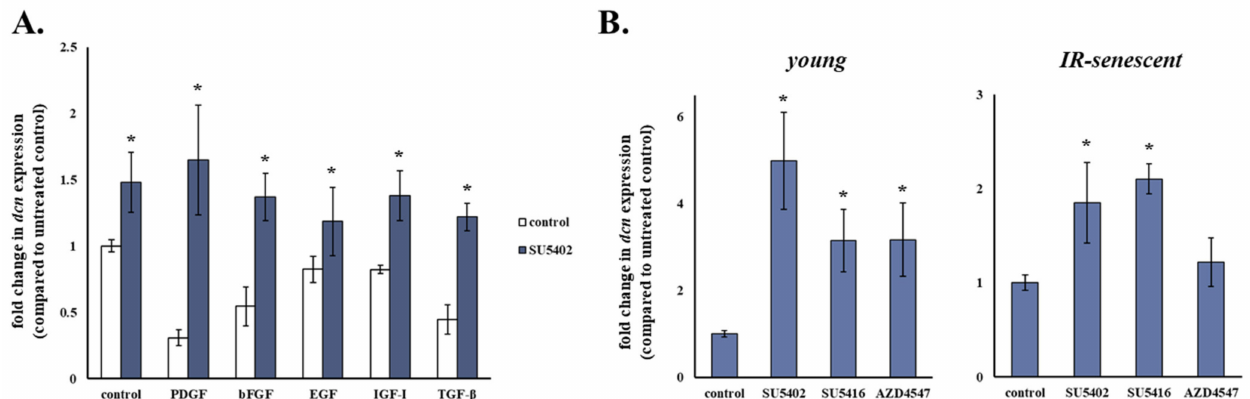
Figure 4. bFGF and VEGF seem to be the key growth factors down-regulating decorin expression in human stromal fibroblasts. ( A ) Human breast stromal fibroblasts were serum starved for 24 h, pre-incubated with 20 µ M of SU5402 for 1 h and then treated with PDGF (10 ng/mL), bFGF (10 ng/mL), EGF (100 ng/mL), IGF-I (100 ng/mL) or TGF- β (5 ng/mL) for another 24 h before RNA extraction, first-strand cDNA synthesis and real-time PCR analysis. ( B ) Young and ionizing radiation-induced senescent human breast stromal fibroblasts were incubated for 24 h with the designated growth factor receptor inhibitors (SU5402 for FGFR and VEGFR (20 µ M); SU5416 for VEGFR (1 µ M); AZD4547 for FGFR (21 nM)). RNA was extracted and decorin (dcn) expression was estimated by RT-qPCR with glyceraldehyde-3-phosphate dehydrogenase (GAPDH) serving as the reference gene. Relative mRNA levels compared to the respective untreated control are presented as means ± standard deviations of three experiments. Statistically significant differences in comparison to the respective control without the inhibitor are marked by asterisks (*) (Student’s t test, p < 0.05). IR: ionizing